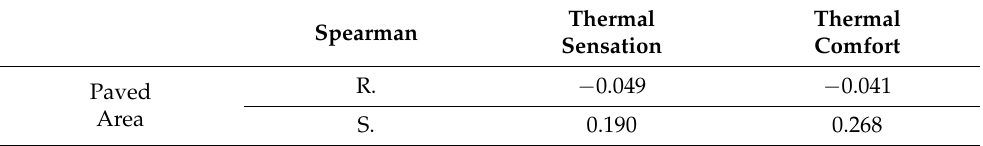
Table 10. Spearman correlation of the paved area ratio with thermal sensation and thermal comfort.